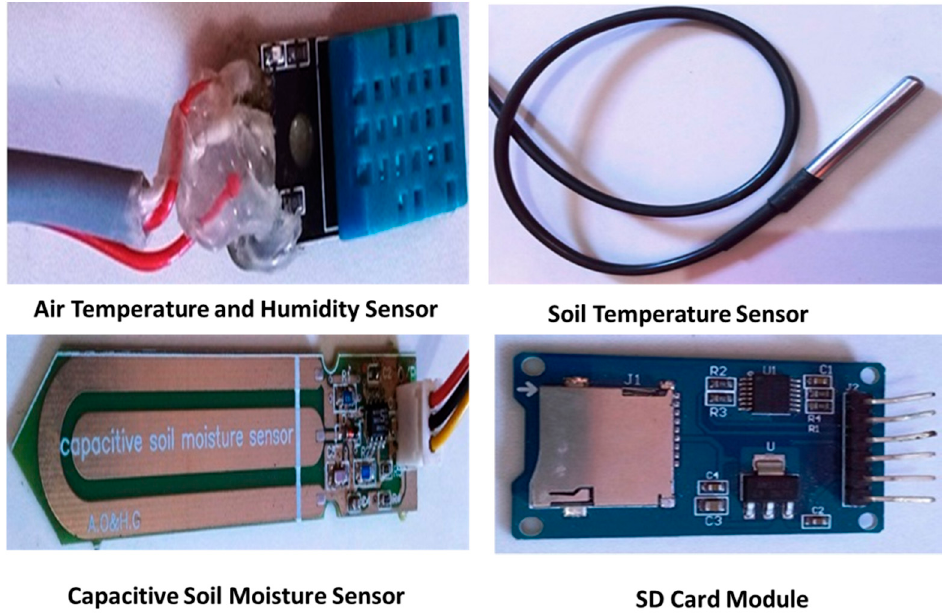
Figure 2. Different hardware components of the smart monitoring unit.